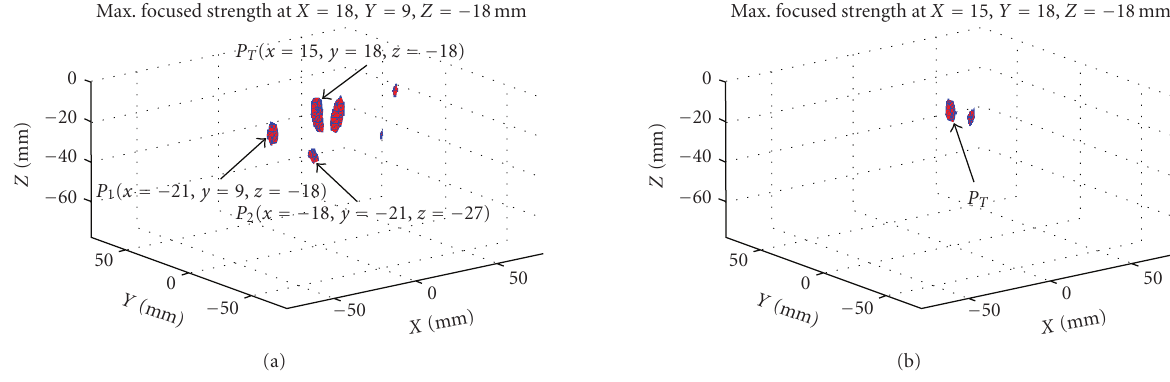
Figure 3: Detection results of a 10mm spherical phantom tumour: (a) standard DAS, (b) improved DAS with QF = a . 3D figures present − 3 dB contour map of scattered energy.